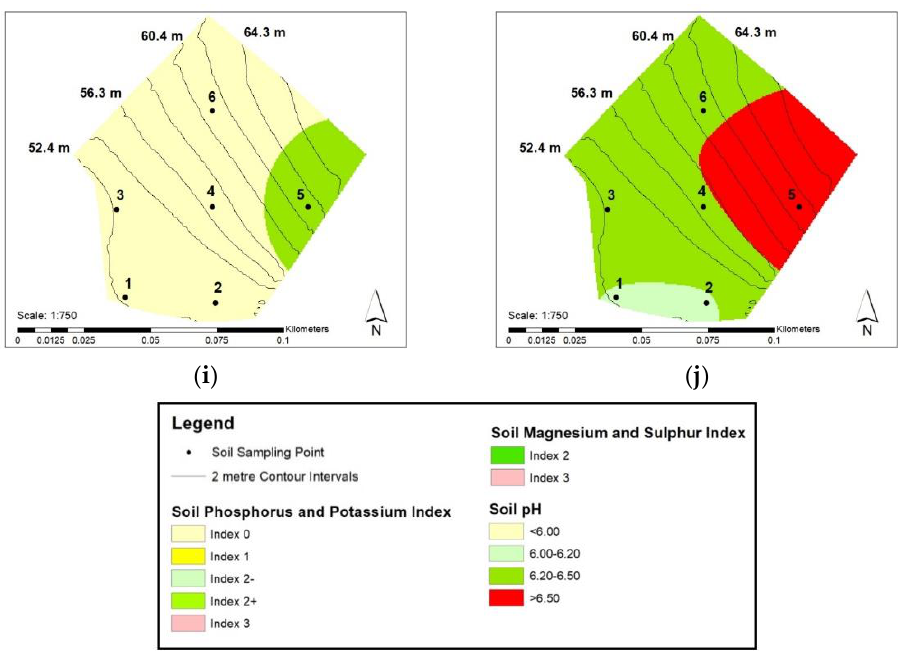
Figure 2. Interpolated soil nutrient content (mg L −1 ) for ( a ) P in 2020; ( b ) P in 2021; ( c ) K in 2020; ( d ) K in 2021; ( e ) Mg in 2020; ( f ) Mg in 2021; ( g ) S in 2020; ( h ) S in 2021; ( i ) pH in 2020 and ( j ) pH in 2021. Included are gridded soil sampling points and 2-metre contour intervals. Table 3. Calculated percentage change in soil total N (%) and soil total C (%) from 2020 to 2021 per gridded sample point. Absolute value change from 2020 to 2021 is given in brackets. Green (yellow) coloured cells indicate a decrease (increase) in nutrient content from 2020 to